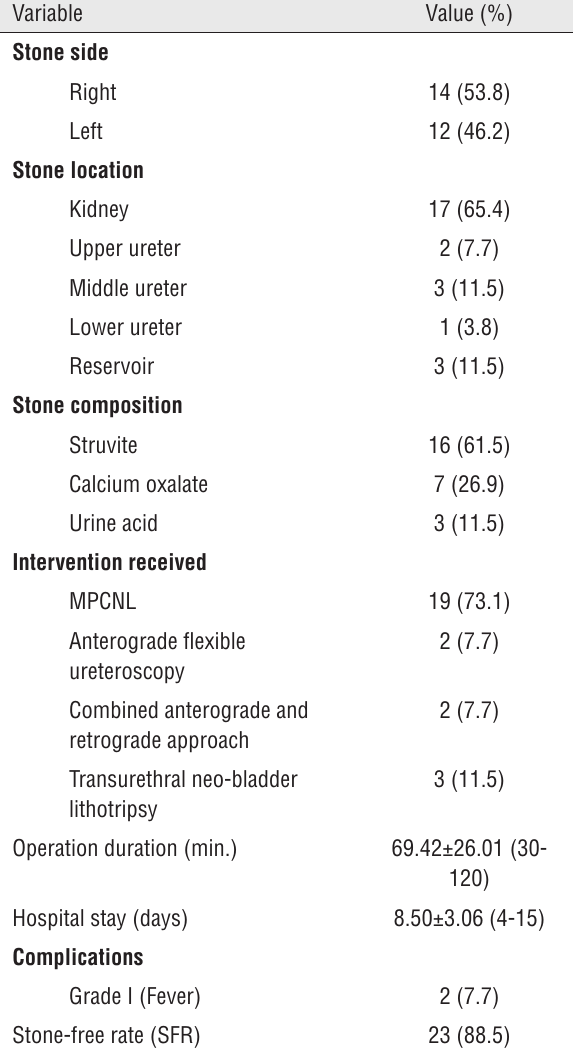
Table 2 - stone criteria and treatment results